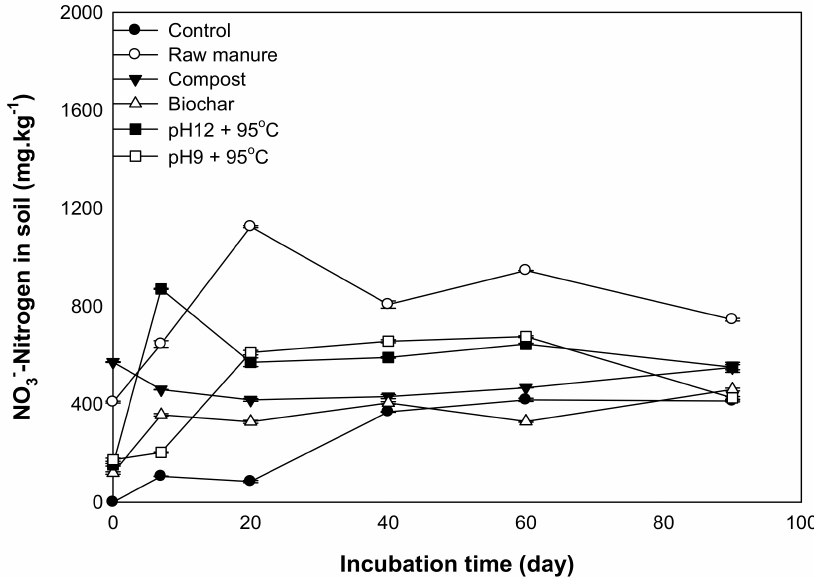
Figure 8. Available NO 3 − mg kg − 1 affected by different organic amendments derived from cow manure at different incubation